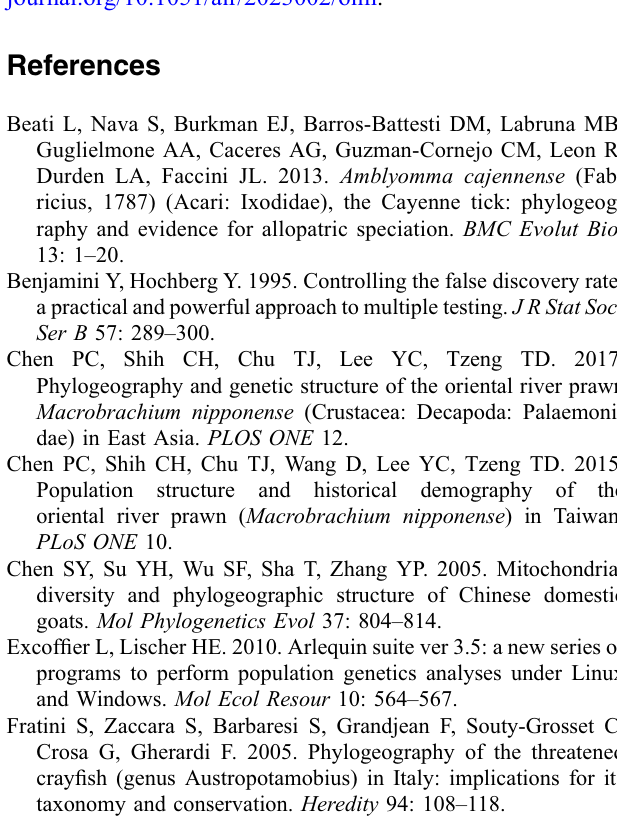
Table S1. The nucleotide composition from 11 M. nipponense populations. Table S2. Distribution of haplotypes of 11 M. nipponense populations. Table S3. Neutrality tests for11 M. nipponense populations Figure S1. A location map for the 11 inferred populations of